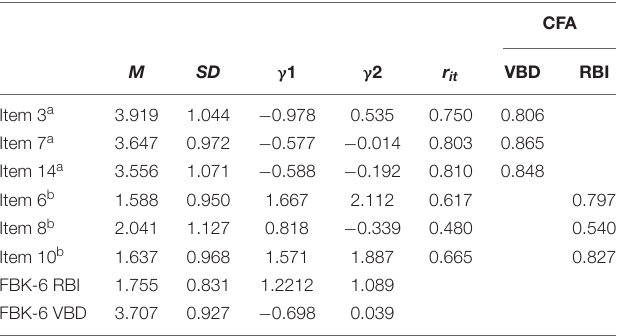
TABLE 3a | Item descriptive statistics and factor loadings in confirmatory factor analysis real body image—version.